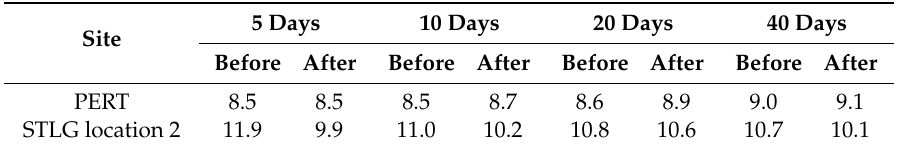
Before After Before After